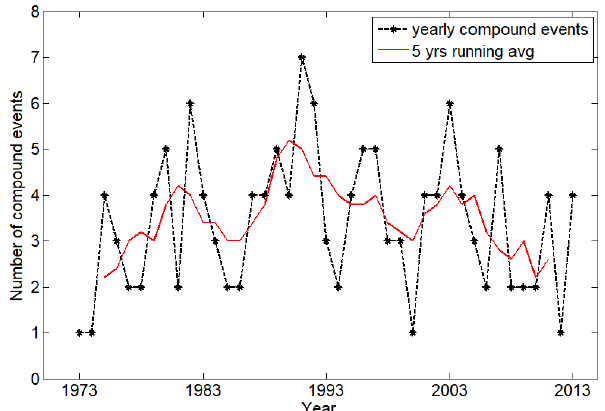
Figure 5. Annual number of compound events (black) and the run- ning 5-year average (red) for the period